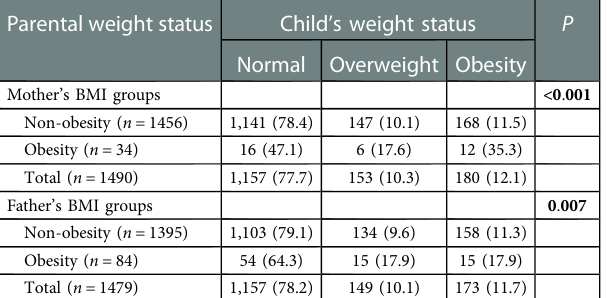
TABLE 2 Prevalence of overweight and obesity among children with different parental weight status. Parental weight status